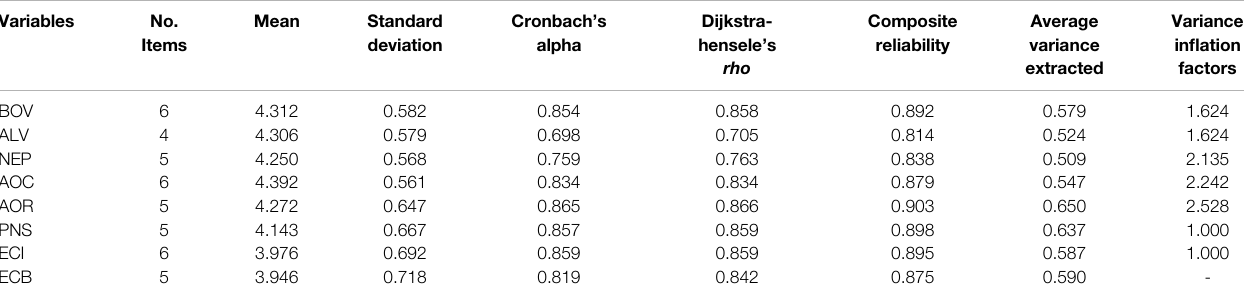
TABLE 2 | Reliability and validity.